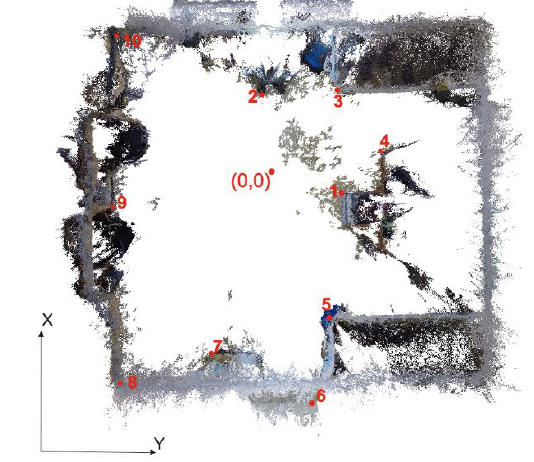
Figure 10. Distribution of checkpoints in the analysed